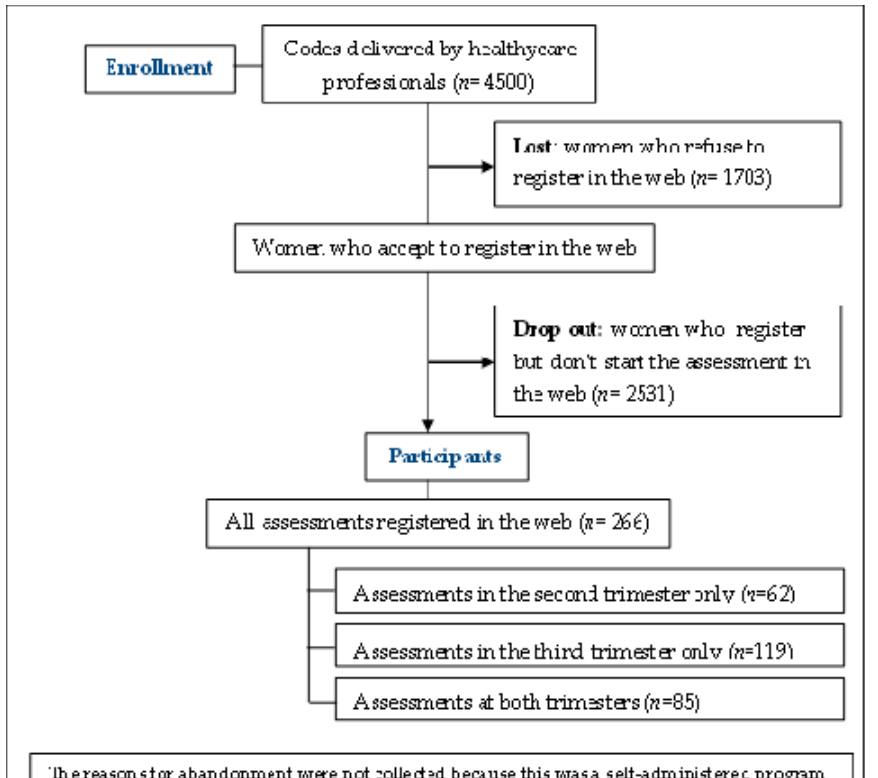
Figure 1. Flow chart of the participants in the study.